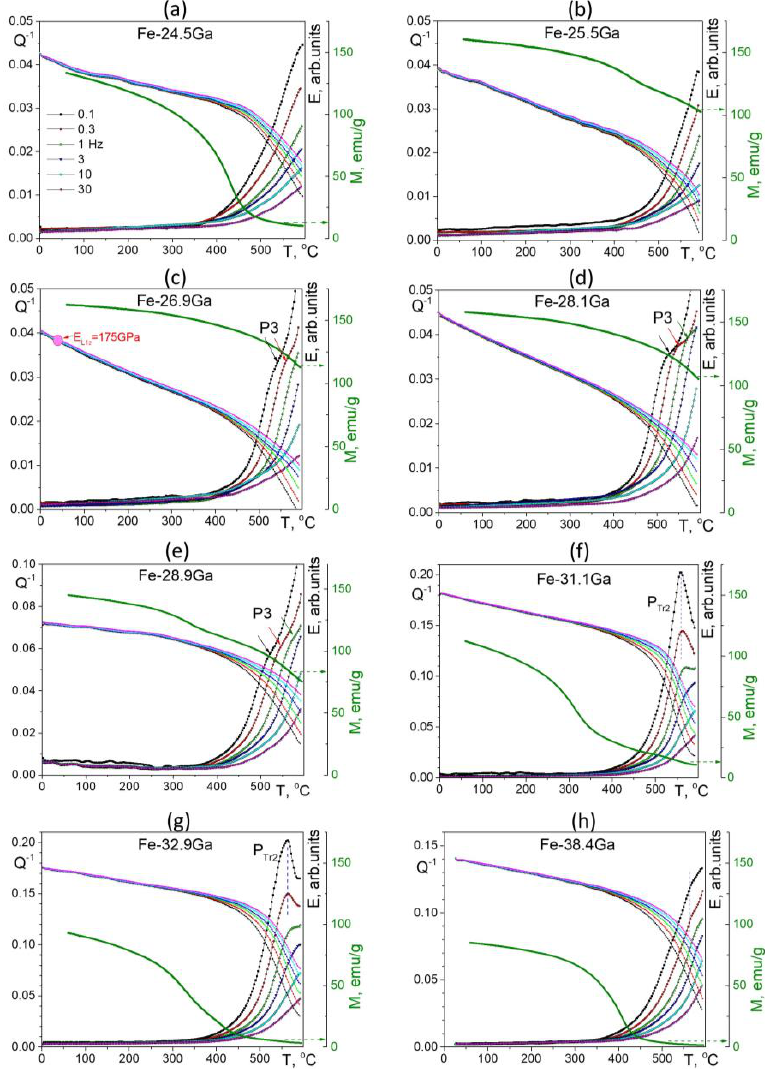
Figure 28. Q −1 (T), E(T) (cooling rate 2 °C /min) and M(T) (cooling rate 6 °C/min) curves at